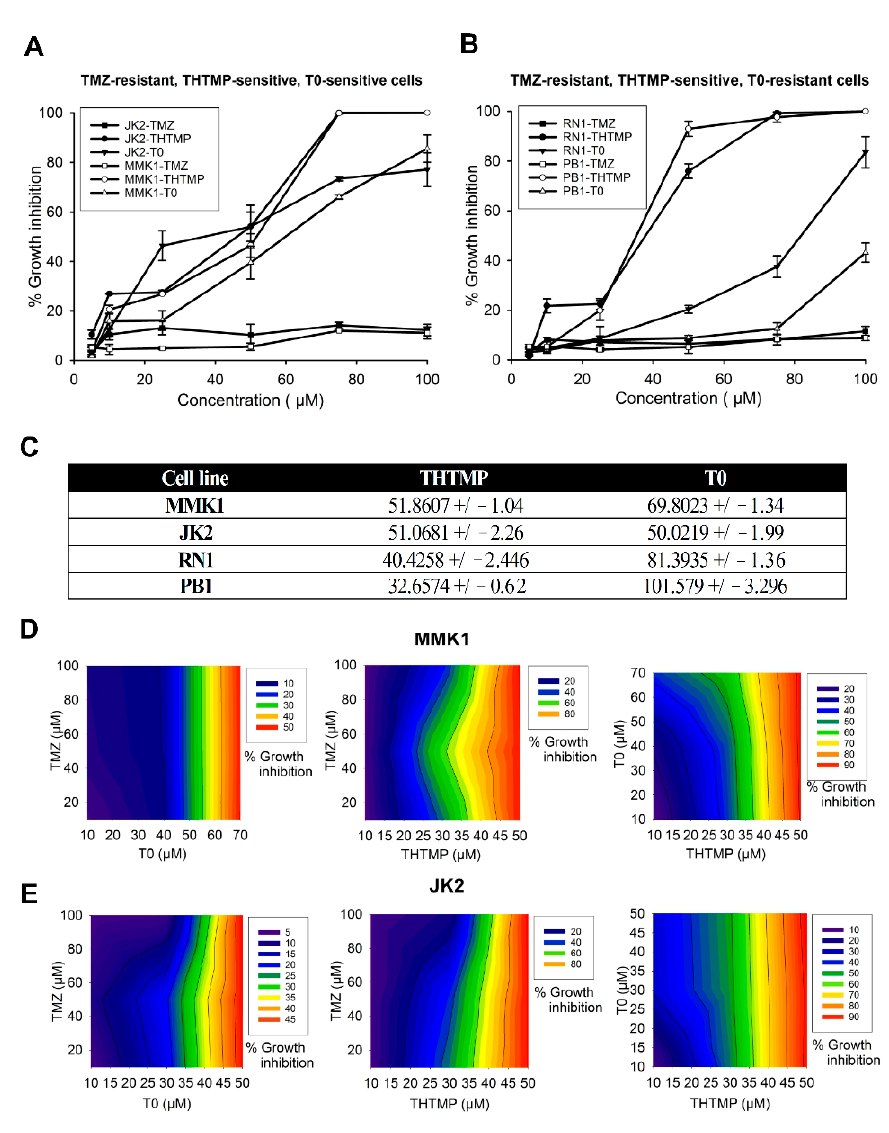
Figure 1. Effect of single and combination treatment of alkylaminophenol (THTMP) and GPR17 agonist (T0) on cell growth inhibition in multiple GBM patient tumor tissue-derived cells. The characteristics of TMZ-resistant, THTMP-sensitive, T0 sensitive cells ( A ), TMZ-resistant, THTMP- sensitive, T0-resistant cells ( B ) were observed at 48 h post-treatment. The IC 50 values of THTMP, T0 for multiple GBM patient tumor tissue-derived cells ( C ). Cells treated with different combinatorial conditions, TMZ + T0, TMZ + THTMP, and THTMP + T0 with a series of concentrations (10 µ M, 25 µ M, 50 µ M, 75 µ M and 100 µ M) on MMK1 ( D ) and JK2 ( E ). The data were shown as means ± SD, with n =